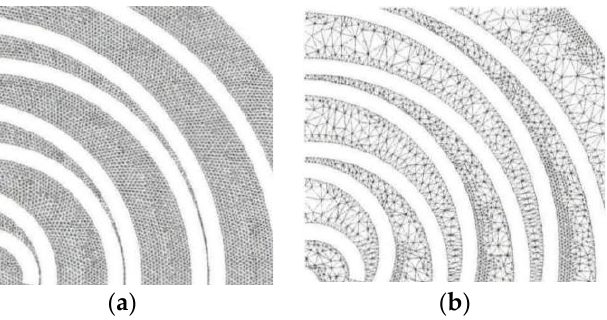
Figure 26. Unstructured dynamic meshes [116]. ( a ) Initial grid; ( b ) reconstructed grid.